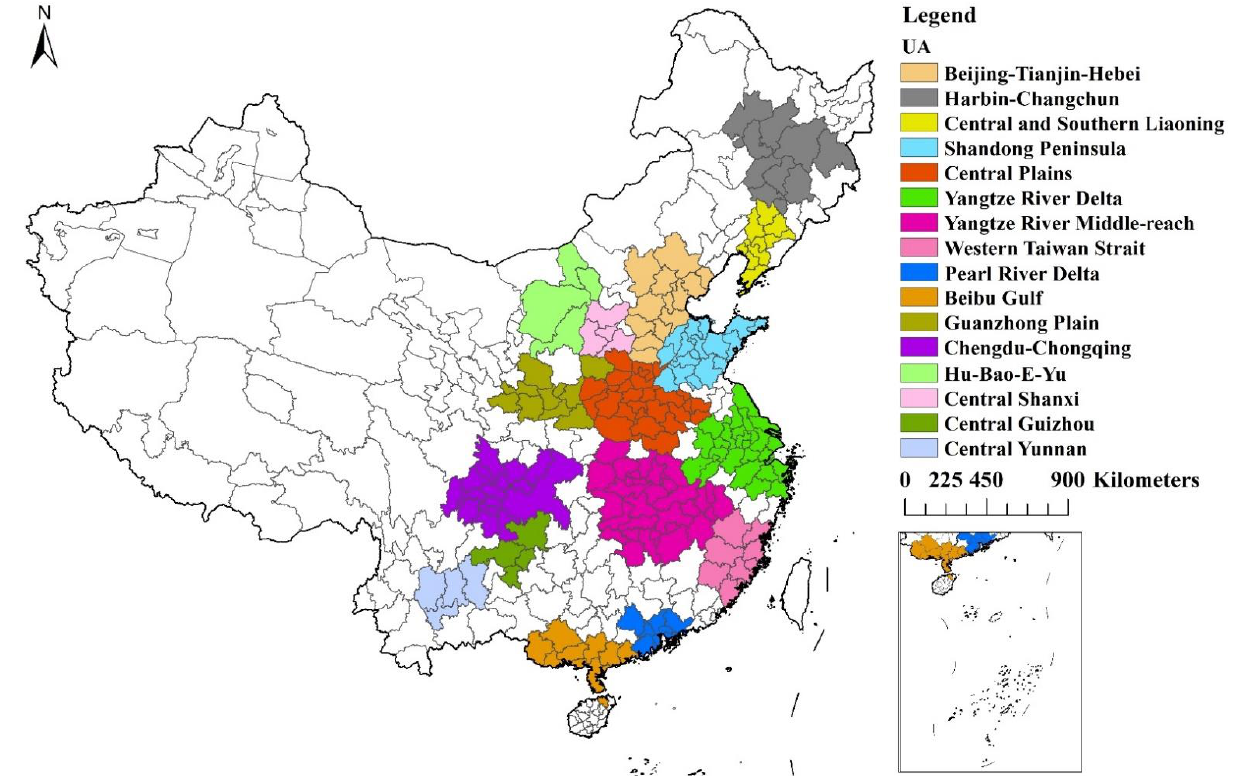
Figure 3. Locations of the study area.